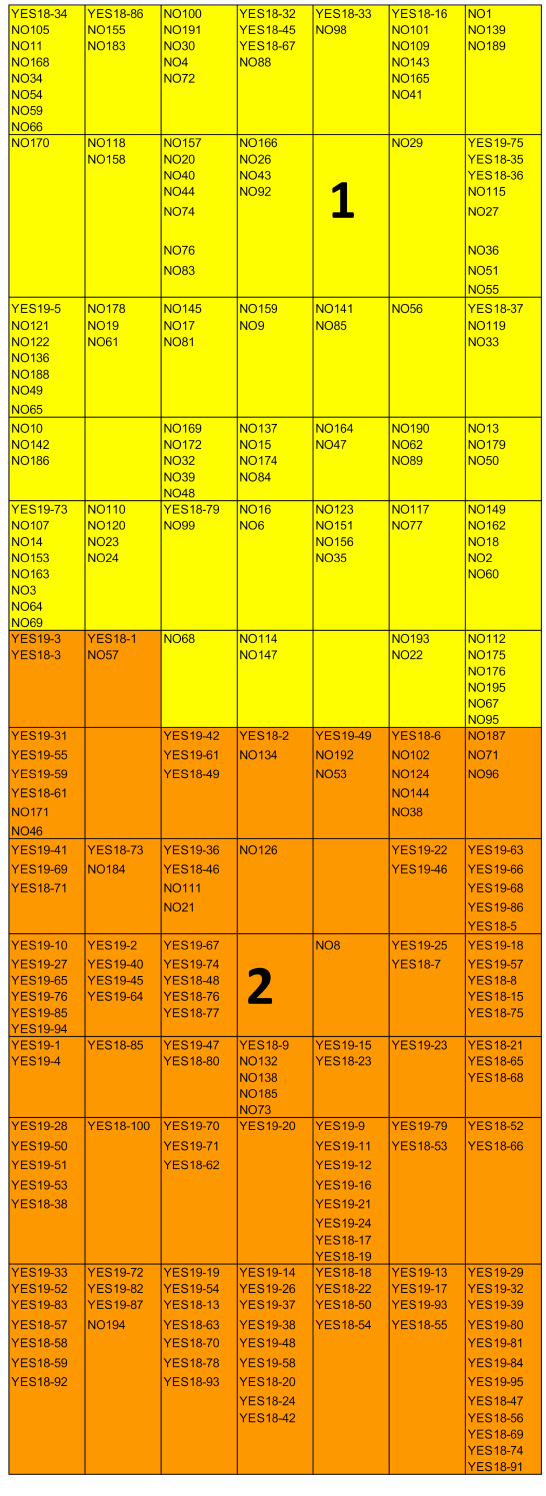
Figure 2. Self Organizing Maps (SOM) for Spanish mutual